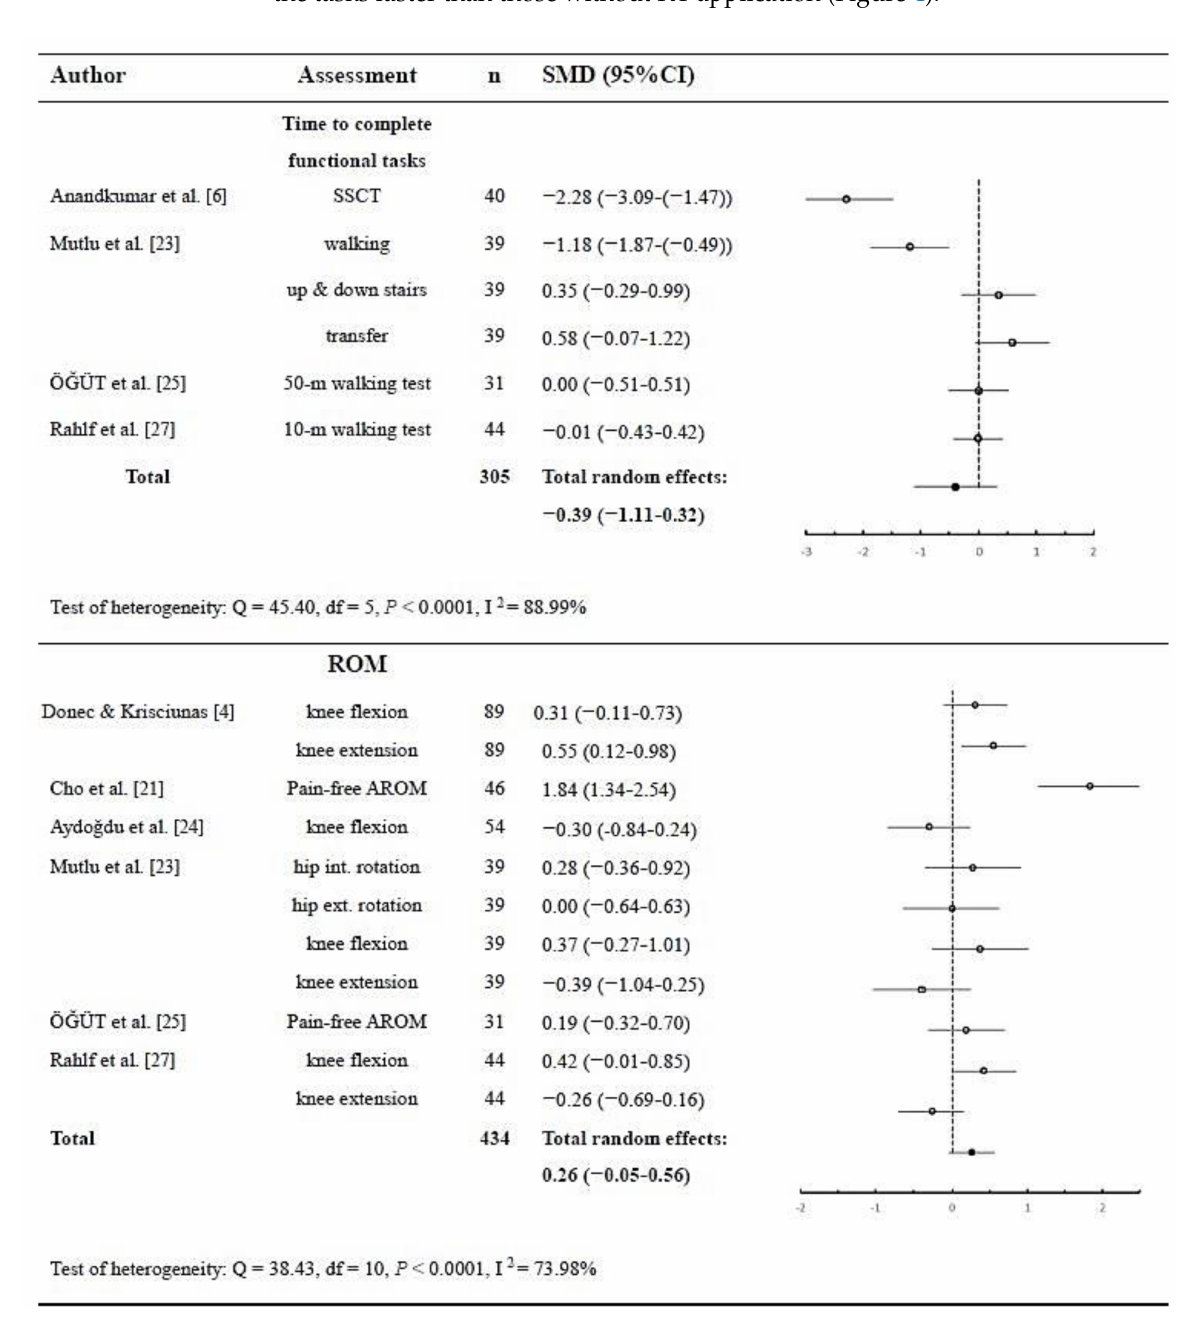
Figure 4. Pooled estimate of the effects of kinesio taping in completing functional tasks and range of motion ( n = number of subjects; SMD = standard mean difference; SSCT = standardized stair climbing task; ROM = range of motion; AROM = active range of motion; int. = internal, ext. = external; df = degree of